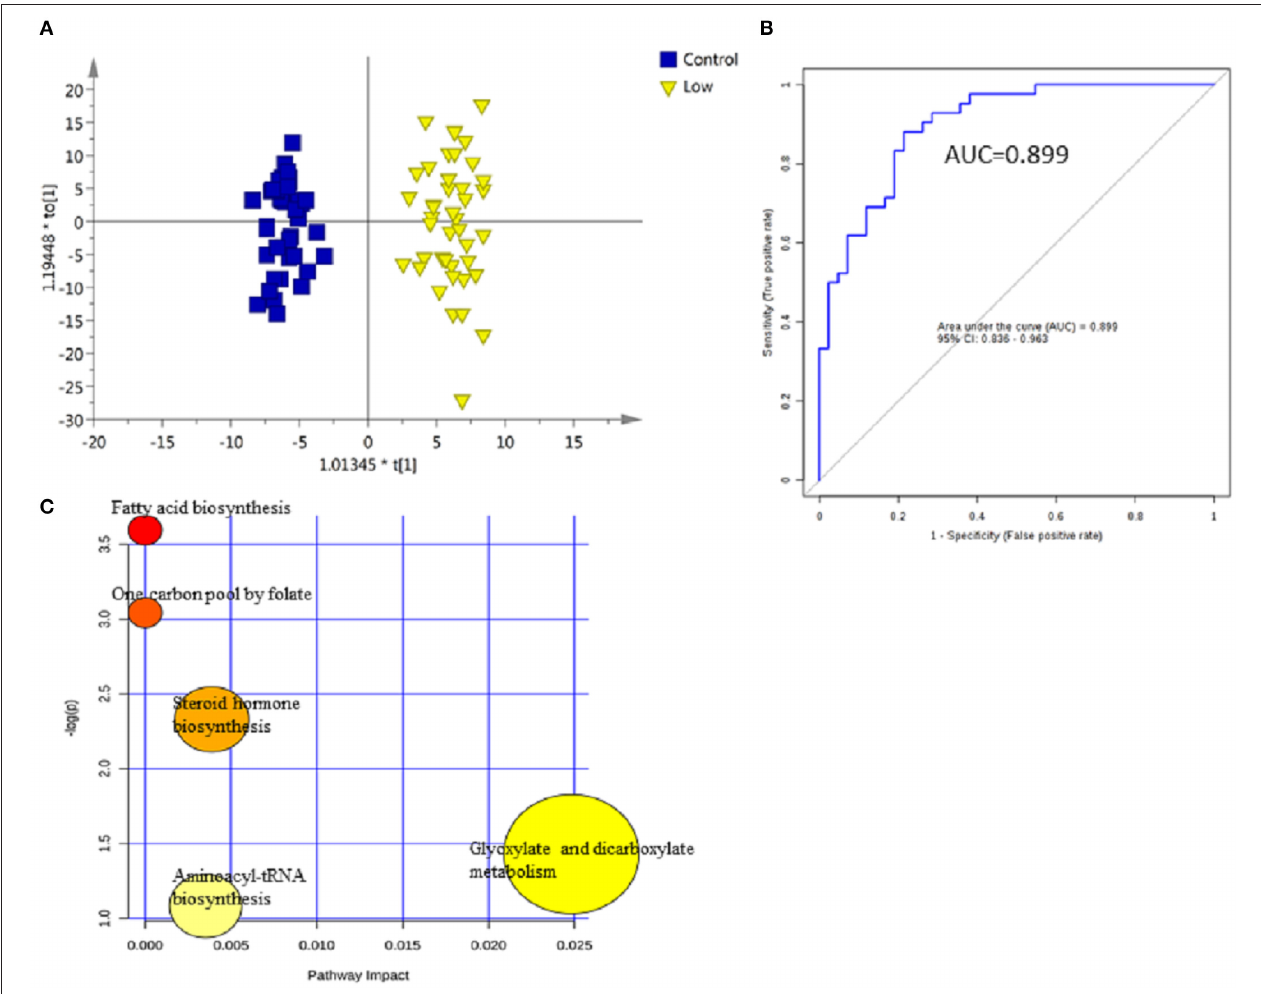
FIGURE 3 | Analysis of metabolic profiling in low-grade NMIBC compared with control group. (A) Score plot of OPLS-DA model based on metabolome between low-grade NMIBC and control group. (B) ROC plot with 10-fold cross-validation based on model of 3-Hydroxy-cis-5-tetradecenoylcarnitine, 6-Ketoestriol, Beta-Cortolone, Tetrahydrocorticosterone, and Heptylmalonic acid to quantify the discrimination degree of low-grade NMIBC and control group. (C) Pathway analysis of differential